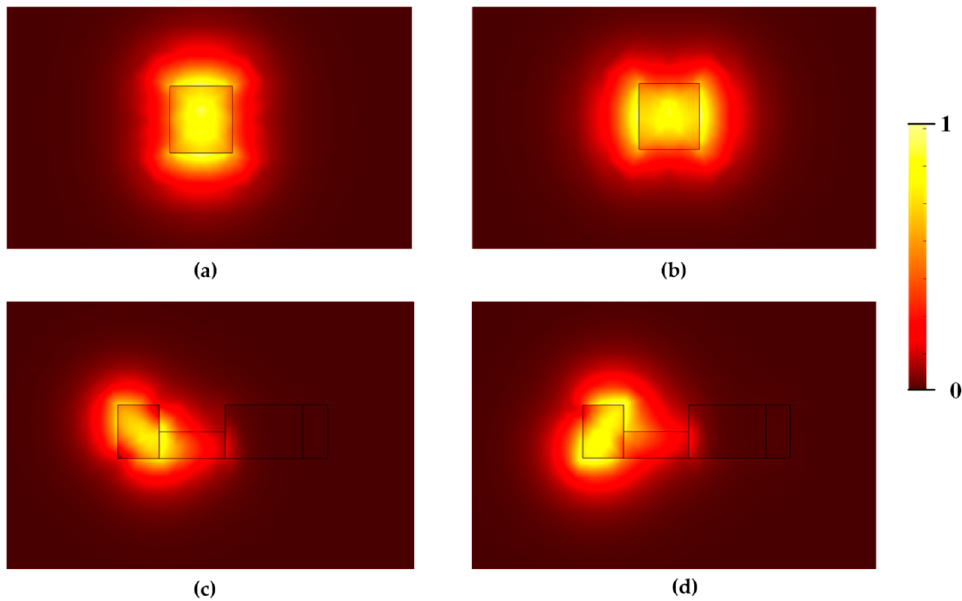
Figure 2. Mode field distributions of the fundamental ( a ) TM and ( b ) TE modes supported by the input strip waveguide. ( c , d ) Optical axis is deflected by 45 ◦ at the middle of L 2 . Some of the structural parameters of this PSR are as follows: the relative refractive indices of silicon and silica were taken as 3.478 and 1.444, respectively (at 1.55 µ m); the height of the partially etched area was 170 nm and the rest was 340 nm. Below the silicon layer was the oxide buried layer with a thickness of 2 µ m, and the cladding layer was also 2 µ m thick.